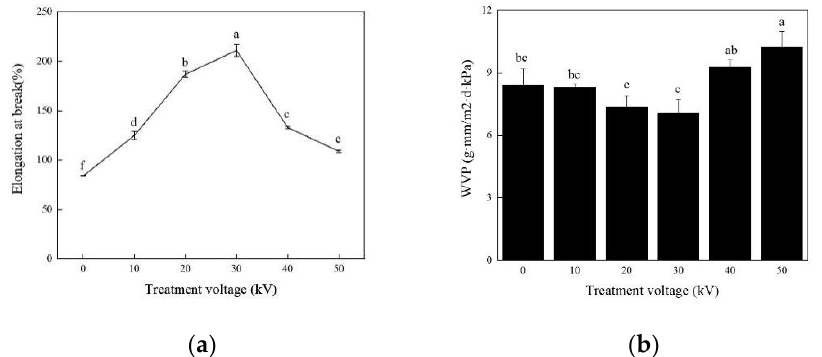
Figure 4. Effects of ACP treatment voltages on elongation at break and WVP of the soy protein film. ( a ) Elongation at break; ( b ) WVP. Different lowercase letters denote significant differences ( p < 0.05).